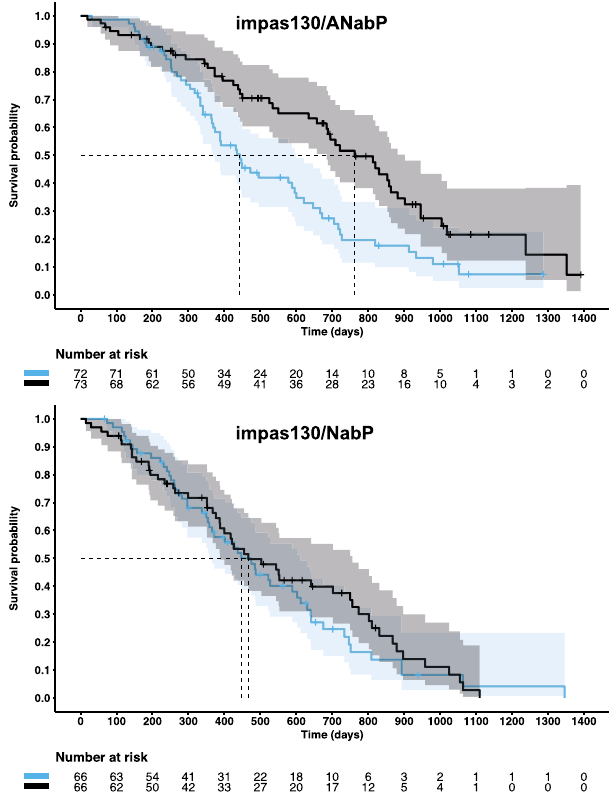
Fig. 4 Polygenic risk for hypothyroidism is associated with lower risk of death in European ancestry TNBC patients treated with atezolizumab and nab-paclitaxel. Kaplan – Meier (KM) plot for OS for triple-negative breast cancer (TNBC) patients of European ancestry treated with atezolizumab plus nab-paclitaxel (top) and placebo plus nab-paclitaxel (bottom) from IMpassion130. Patients were split into two groups on the basis of median split of the hypothyroidism PRS (hypoT) across all European ancestry IMpassion130 patients with germline genetic data. Censoring events are denoted by vertical dashes. Dashed horizontal and vertical lines designate the median survival time. Shaded regions provide the 95% con fi dence intervals. impas130 = IMpassion130. A = atezolizumab; NabP =